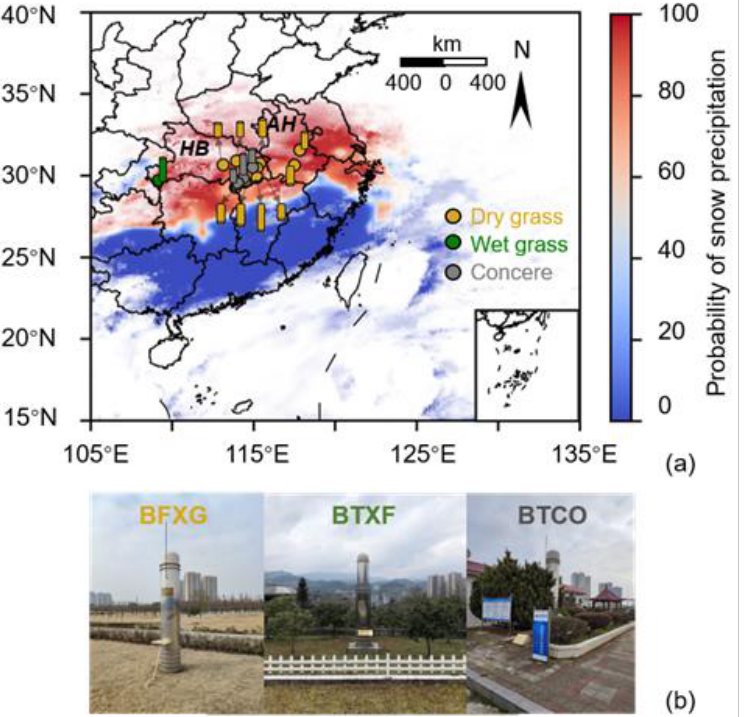
Figure 1. The study area and the locations of the GNSS/MET sites. ( a ) Distribution of the GNSS sites and their ground surface substances; HB: Hubei; AH: Anhui. The areas affected by the snowstorm were defined by the probability of snow precipitation derived from the IMERG late precipitation L3 half-hourly product (23:30~24:00) on 6 February. The in situ snow depths for individual sites on 6 February are illustrated by bars. ( b ) Photos of typical GNSS sites with three ground surface substances. “BFXG”: dry grass, “BTXF”: wet grass, “BTCO”: concrete. Table 1. Detailed information of the 13 GNSS sites used in this